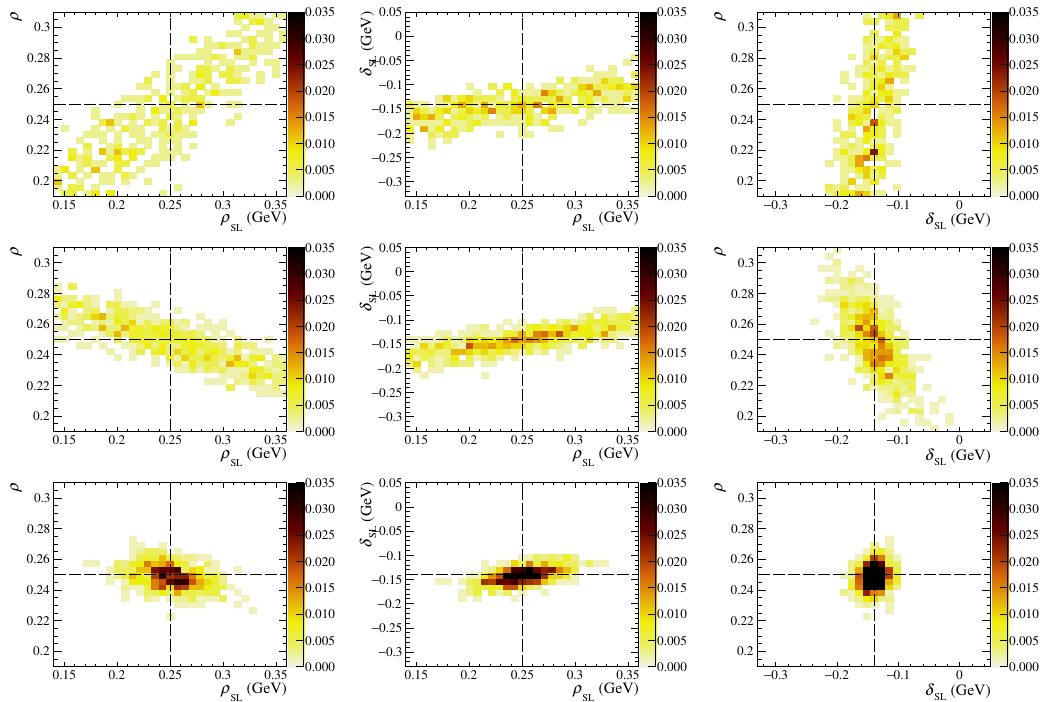
Figure 6 . Two-dimensional distributions of the Isgur-Wise parameters as (cid:12)tted from an ensemble of pseudoexperiments. Both q 2 and cos (cid:18) l are (cid:12)tted simultaneously. Only simulated (cid:3) c (2595) + and (cid:3) c (2625) + data are used for the pseudoexperiments shown in the (cid:12)rst and second row, respectively. Both states are (cid:12)tted in the pseudoexperiments shown in the third row. The dashed lines indicate the numerical values of the parameters used to generate the